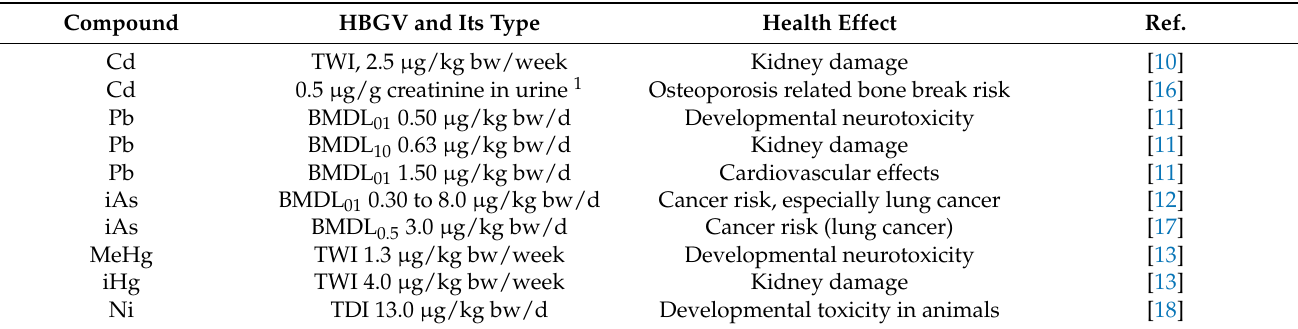
Table 1. Health-based guidance values (HBGV) for dietary intake of the heavy metals, set by the European Food Safety Authority (EFSA) except ref. [16] and ref. [17] used for comparison. HBGV were set separately for inorganic arsenic (iAs), inorganic mercury (iHg) and methyl mercury (MeHg) instead of total amount of metal as for the other compounds. TWI is tolerable weekly intake and TDI the tolerable daily intake; BMDL is the benchmark dose lower confidence limit and its subscript shows the percent change from baseline level. The values are given per kilogram of body weight (kg bw). Compound HBGV and Its Type Health Effect Ref.